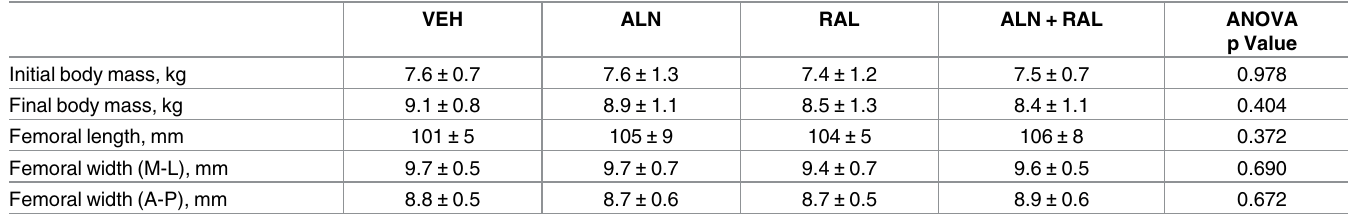
Table 1. Body mass and femoral dimensions.